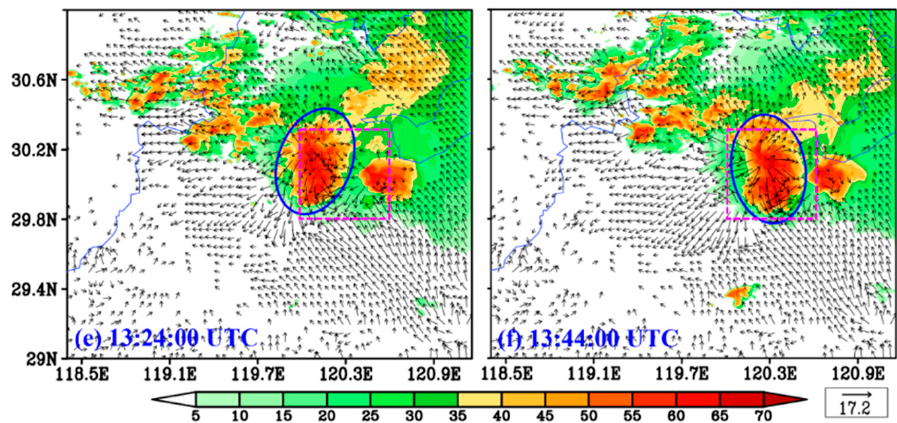
Figure 6. Panels ( a – f ) show the simulated composite radar reflectivity (shading; dBZ) and surface wind speed ≥ 3 m s − 1 (vectors; m s − 1 ), where the blue ellipses outline the targeted system, and the purple dashed boxes show the key region.